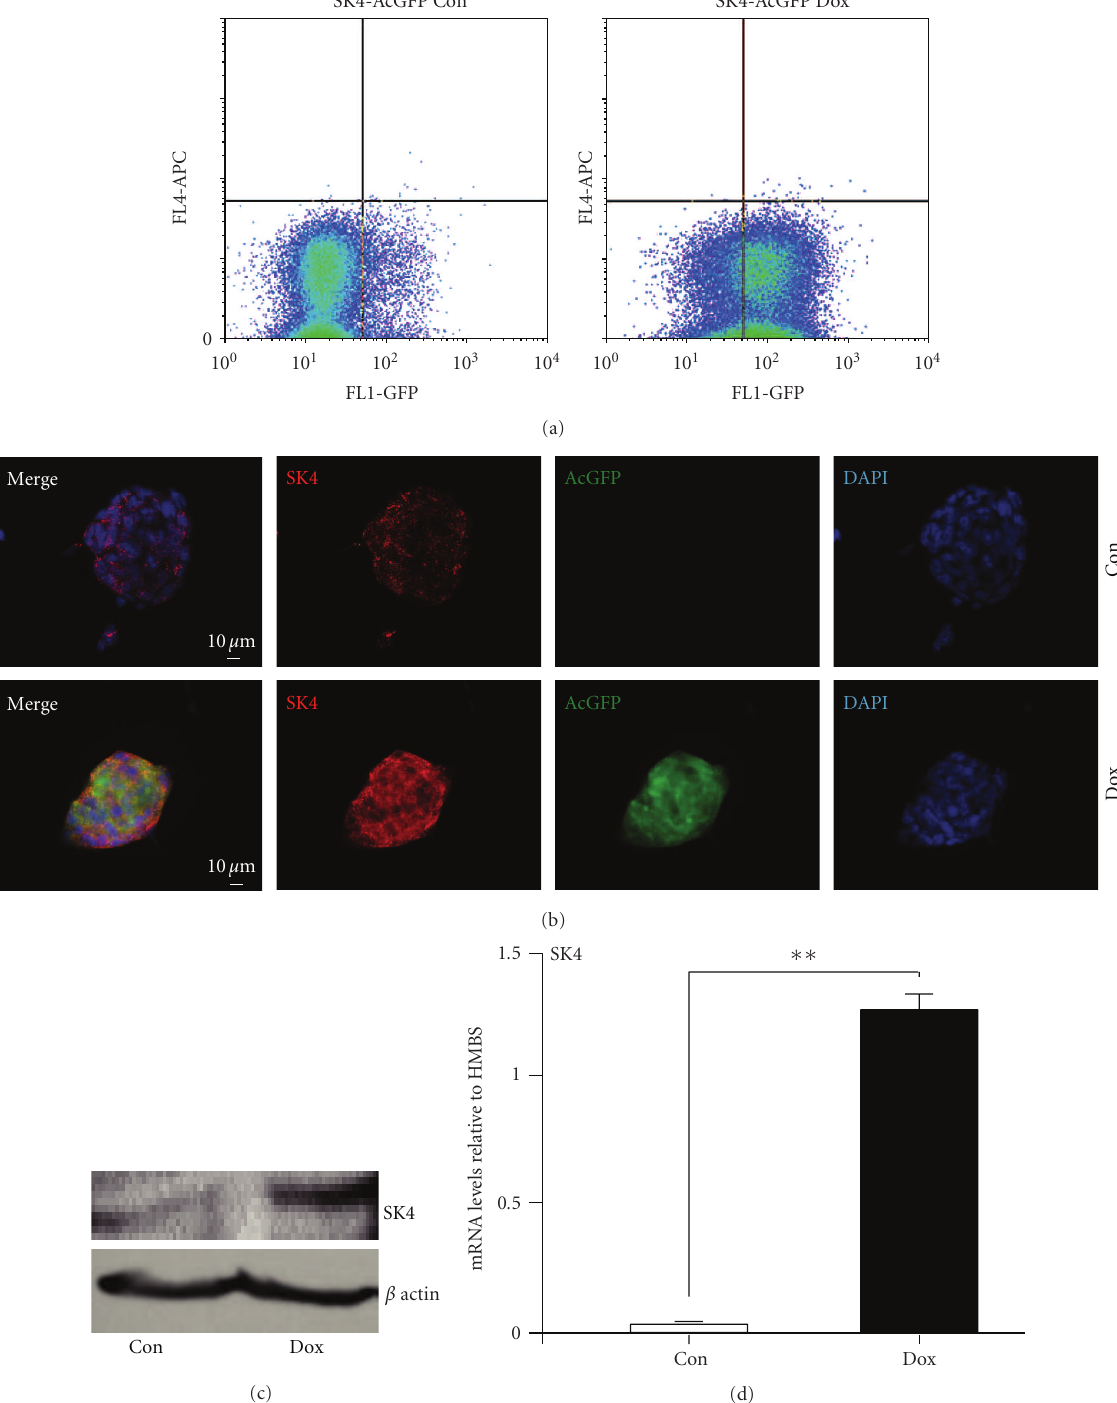
Figure 3: Characterization of iSK4 cells. (a) Flow cytometry by FACS shows a major proportion of the doxycycline-treated cells to exhibit green fluorescence ( > 75%). (b, c) Neomycin-selected iSK4 clonal cultures show dox-dependent elevation of SK4 proteins. (b) Iimmunocytochemistry using specific SK4 antibodies shows highly elevated protein levels of SK4 in the colonies after 1 day of doxycycline treatment. Dox-treated cells exhibit the AcGFP fluorescence (green) in contrast to controls. Both treated and untreated cells express SK4 proteins (red) with a strong increase in the dox-treated cells. Elevated SK4 proteins upon dox treatment was underlined by (c) by immunoblot. Nuclei are stained by DAPI (blue). Scale bars as indicated. (d) SK4 transcript increase upon doxycycline treatment is validated by real-time one-step